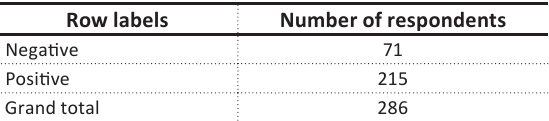
Table 4. Distribution of brand activism response